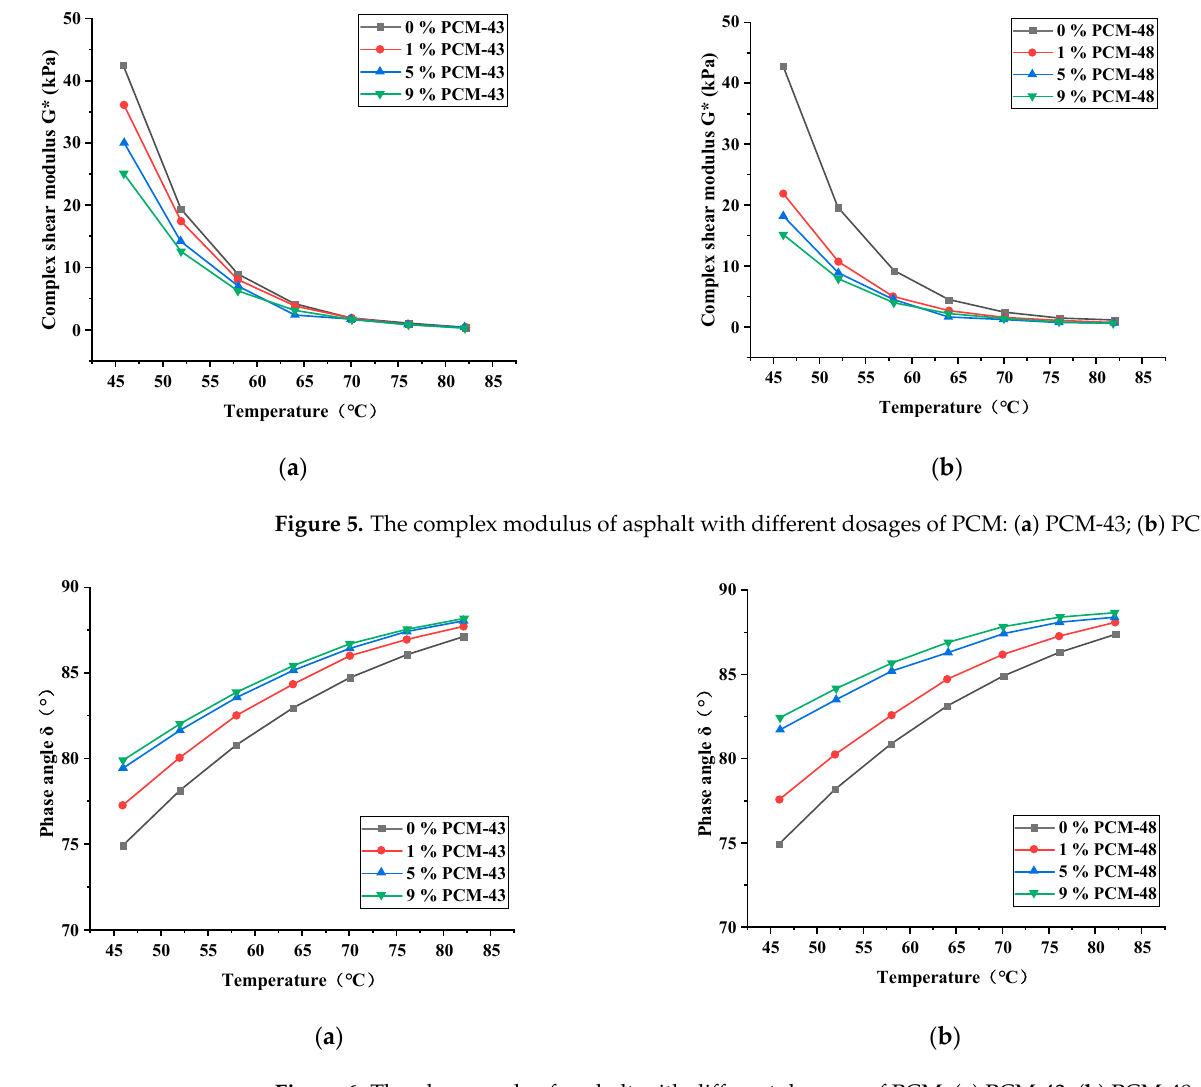
Figure 6. The phase angle of asphalt with different dosages of PCM: ( a ) PCM-43; ( b ) PCM-48. As seen in Figure 7, the trend of the rutting resistance factor is basically the same as the complex shear modulus. The test results indicate that the phase-change material has a slight adverse effect on the high-temperature performance of the asphalt. Comparing the two phase-change materials, PCM-43 has less influence on the high-temperature perfor- mance of asphalt. Additionally, the higher the amount of PCM, the lower the anti-rutting factor at high temperatures. This phenomenon is because the shell material of PCM im- pacts the high-temperature performance of asphalt, so the dosage of PCM should be con- trolled in the asphalt mixture. Figure 7. Rutting factor of asphalt with different dosages of PCM: ( a ) PCM-43; ( b ) PCM-48.